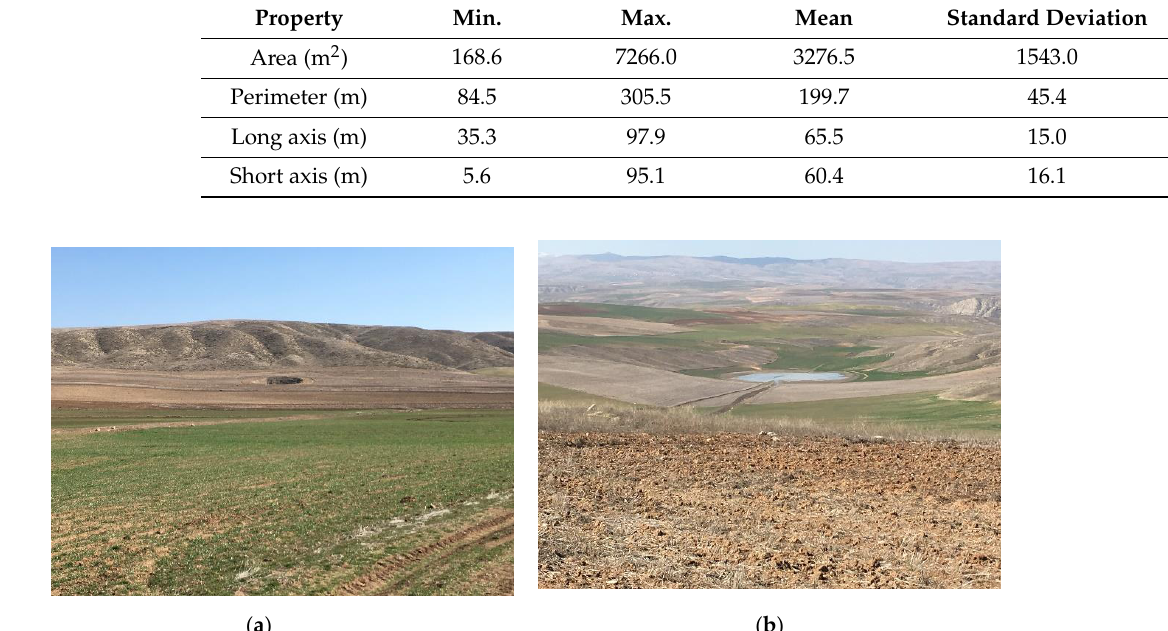
Figure 3. Example views of sinkhole formations observed in the region: ( a ) an example view of a subsidence sinkhole, and ( b ) an example view of a solution sinkhole. (Photographs were taken at the location X = 584,463 m, Y = 4,405,431 m in UTM Projection and WGS84 Datum on 26 February 2019 by H.A.N.).